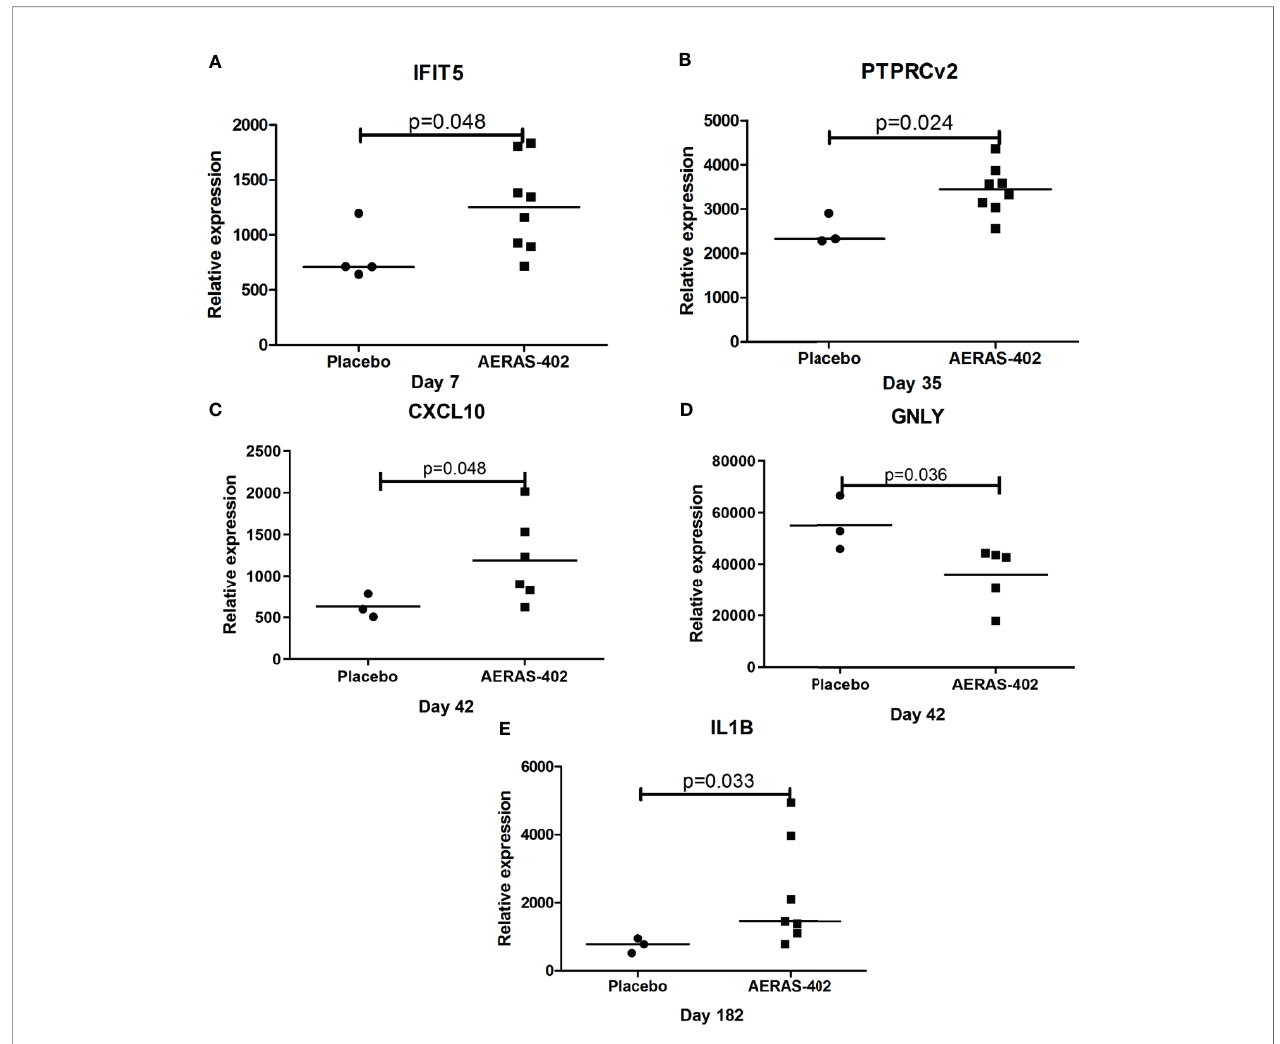
FIGURE 4 | Mann-Whitney test was applied. Dot-plot graph depicting genes that were differentially expressed between the AERAS-402 and placebo recipients. Day 7 (A) ; day 35 (B) ; day 42 (C, D) ; day 182 (E)